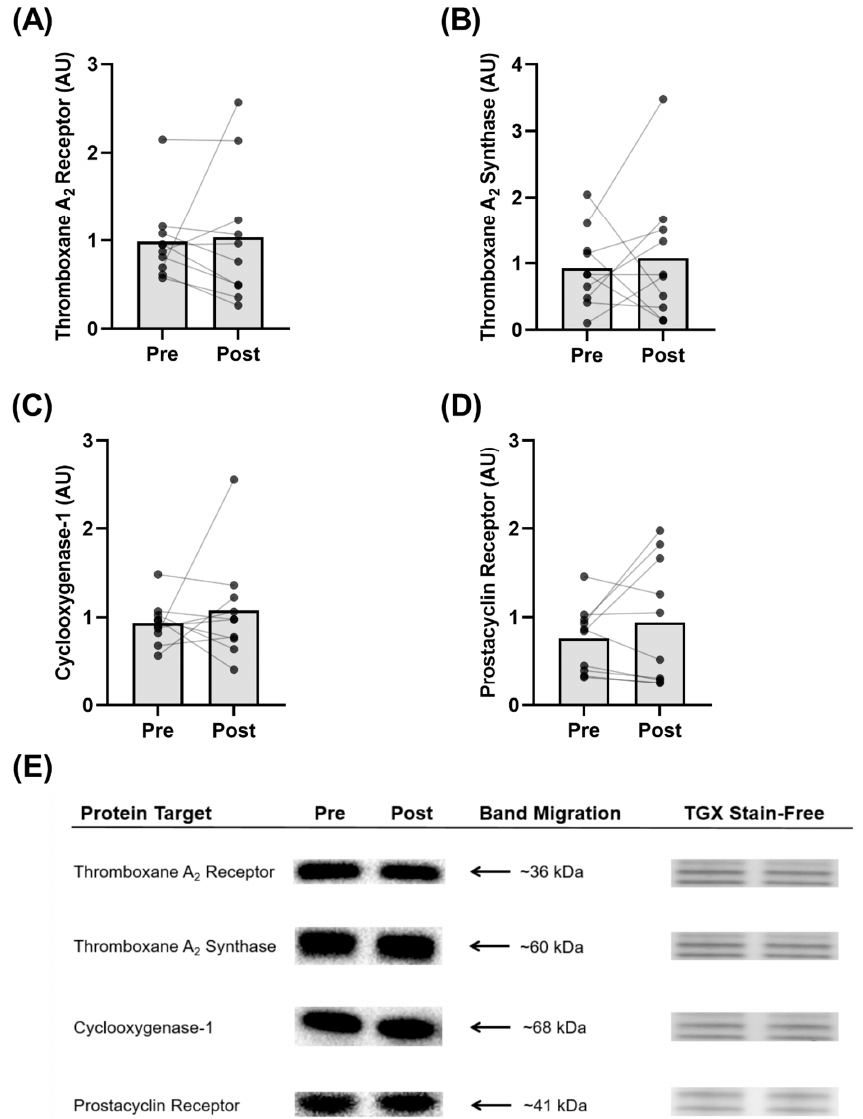
Figure 6. Western blots on platelets isolated from whole blood ( n = 10 for all proteins): ( A ) Throm- boxane A 2 Synthase ( p = 0.829), ( B ) Thromboxane A 2 Receptor ( p = 0.686), ( C ) Cyclooxygenase-1 ( p = 0.844), ( D ) Prostacyclin Receptor ( p = 0.296), and ( E ) Representative Western blots and TGX Stain-Free image. Protein content is expressed in arbitrary units